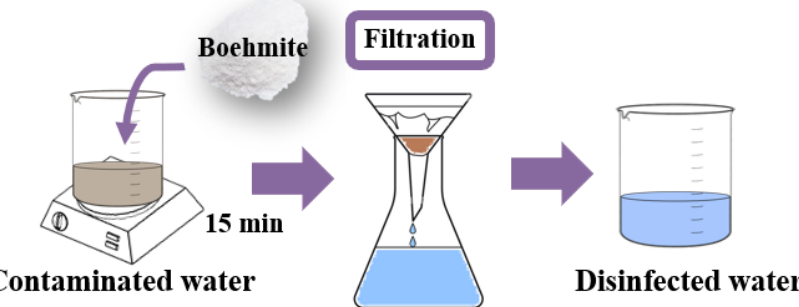
Figure 3. Schematic diagram used for lake water treatment.